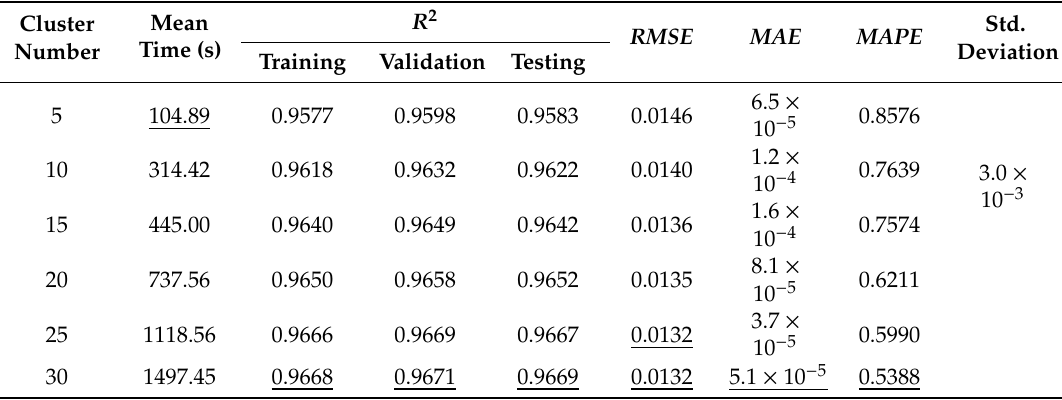
Table 2. Evaluation of the number of clusters considering the FCM